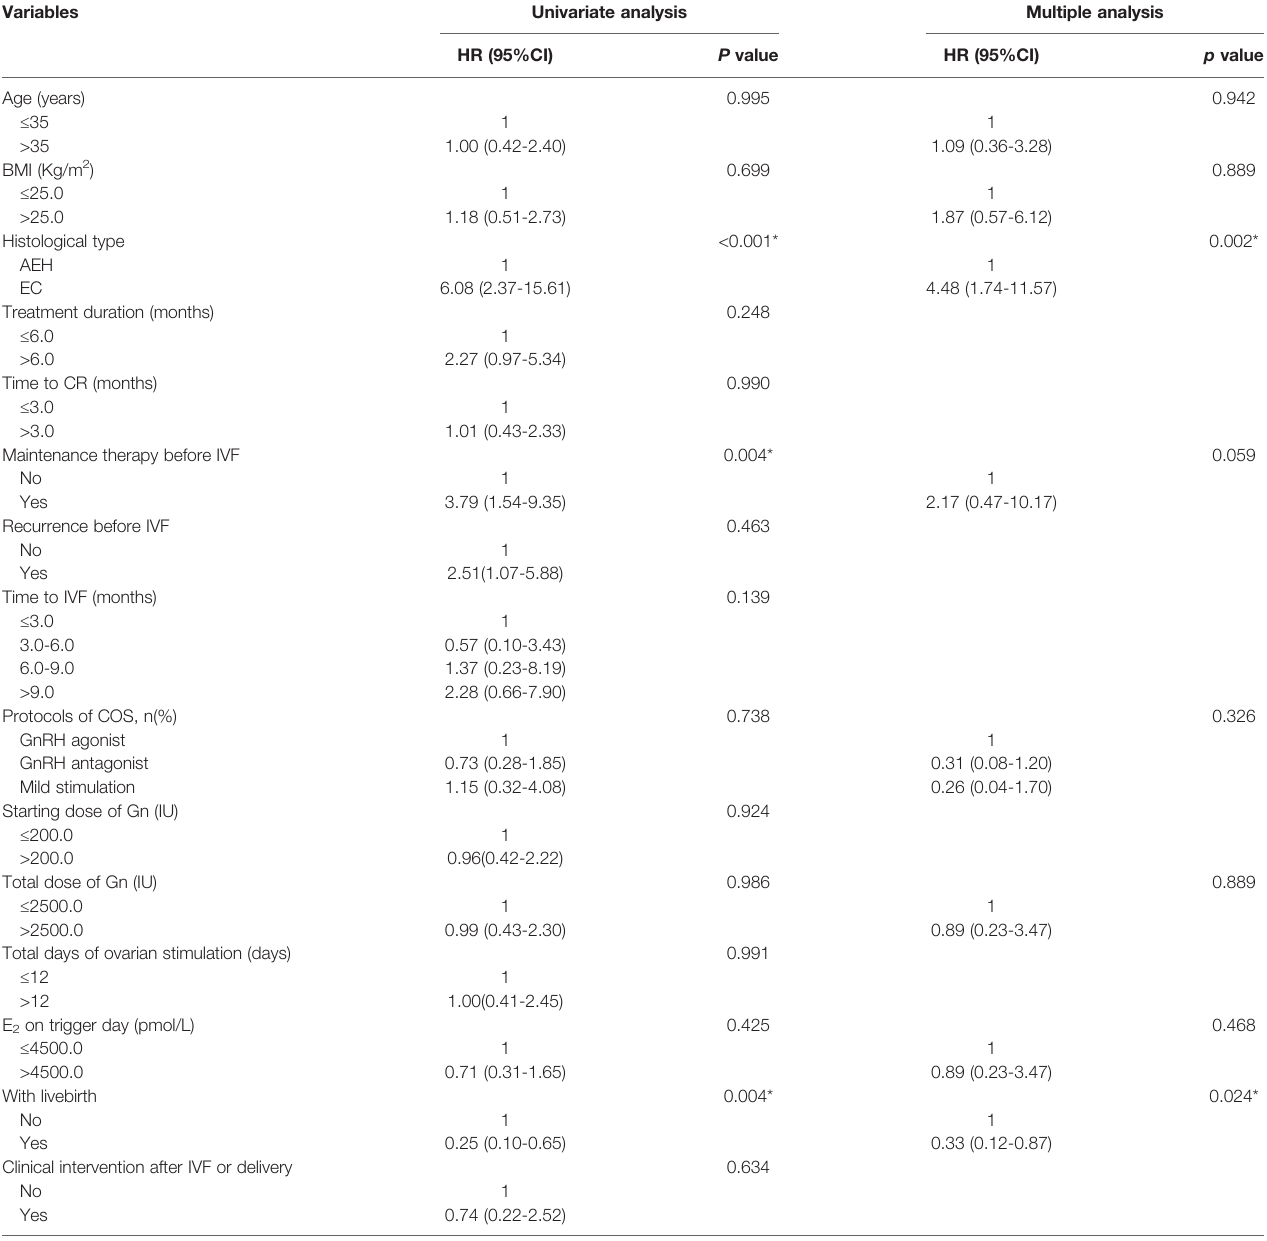
TABLE 5 | Analysis of factors associated with recurrence for patients treated with single COS cycle.